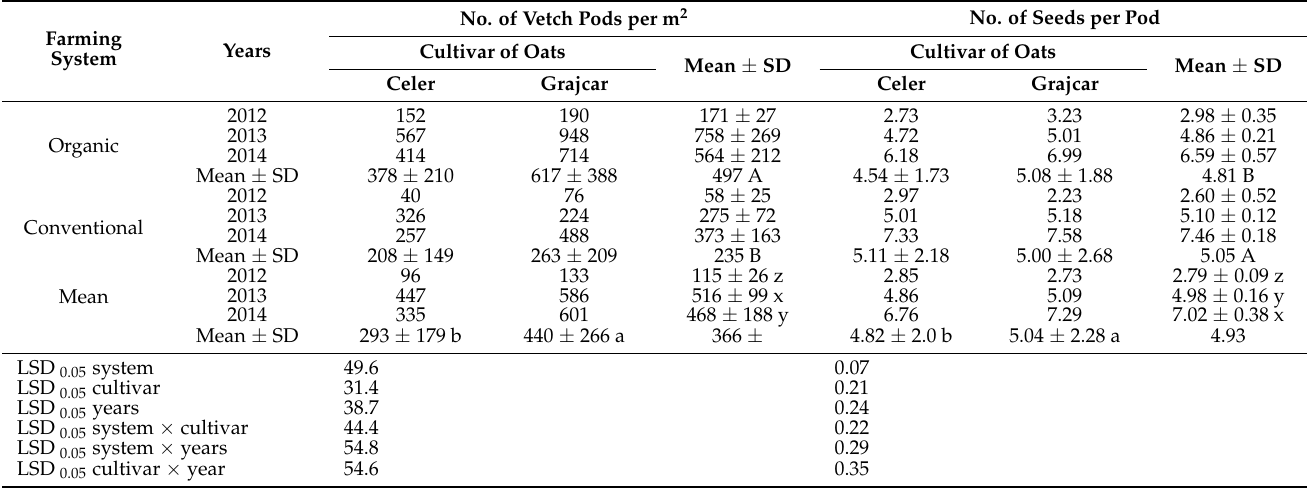
Table 8. The pod number per m 2 and seed number per pod of vetch grown in the oat-vetch mixtures, depending on the farming system and oat cultivar in 2012–2014.